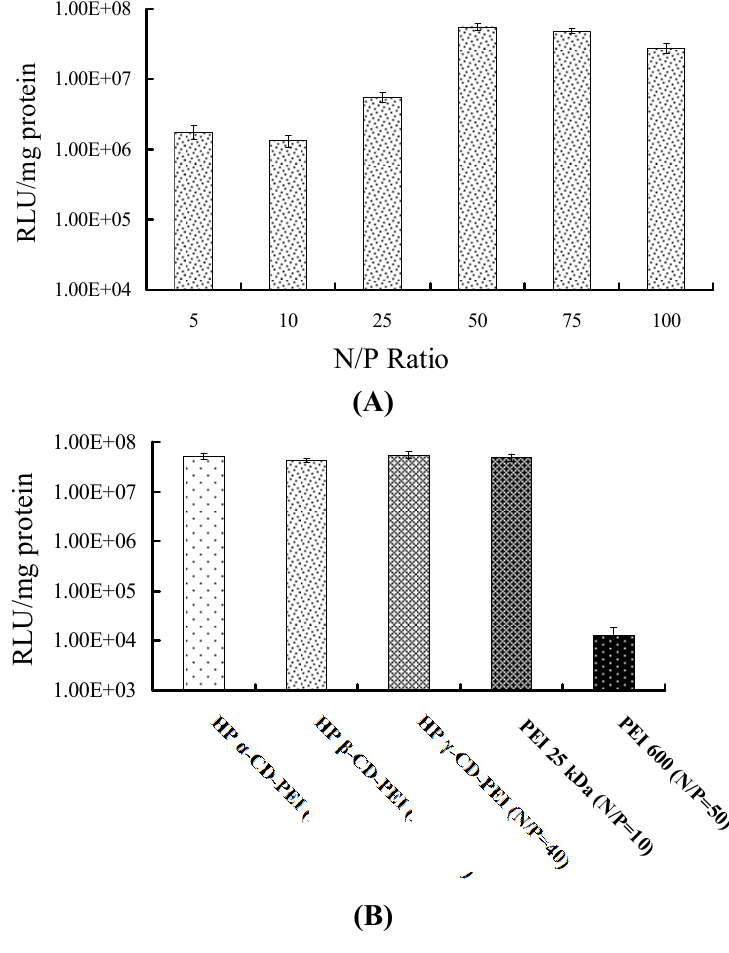
Figure 5. Luciferase assay of co-polymer/DNA complexes in SK-BR-3 cells. (A) HP α - CD-PEI/DNA complexes at different N/P ratios, (B) HP α -CD-PEI/DNA complexes (N/P ratio is 50), HP β -CD-PEI/DNA complexes (N/P ratio is 300), HP γ -CD-PEI/DNA complexes (N/P ratio is 40) and PEI 25 kDa/DNA complexes (N/P ratio is 10).